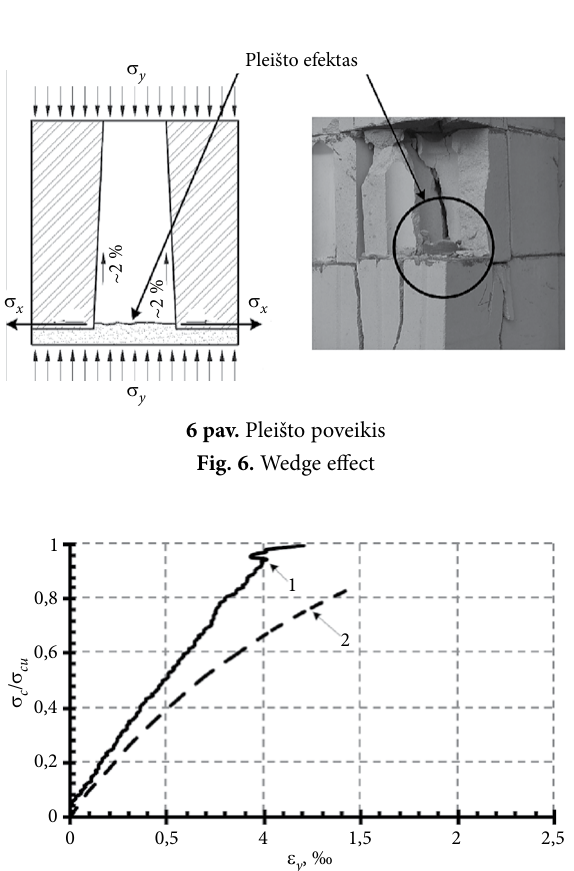
Fig. 7. Stress-strain curves of calcium-silicate and mortar